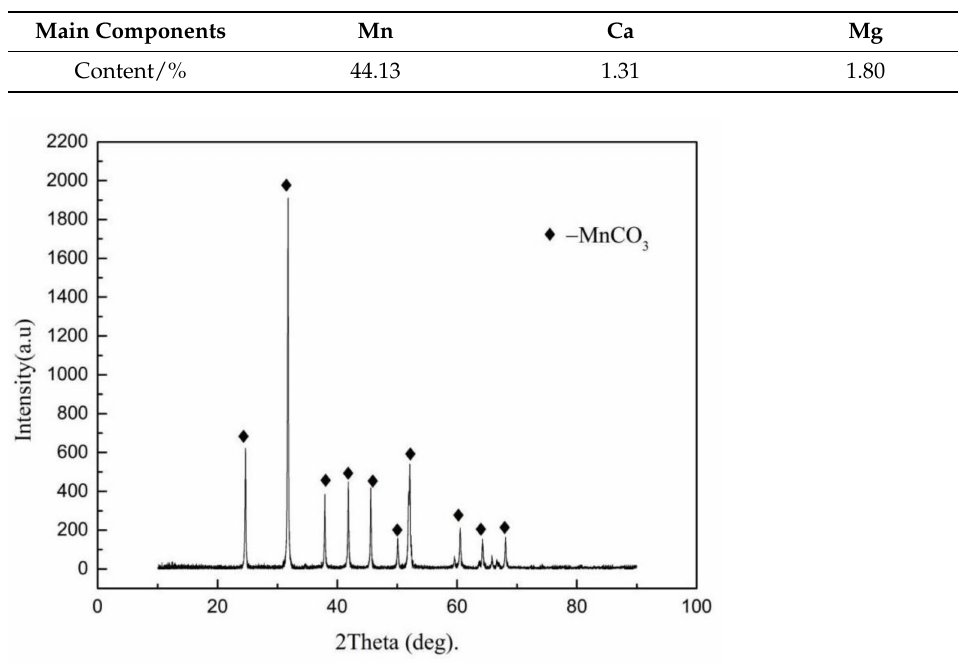
Table 6. Quality analysis results of manganese carbonate products.